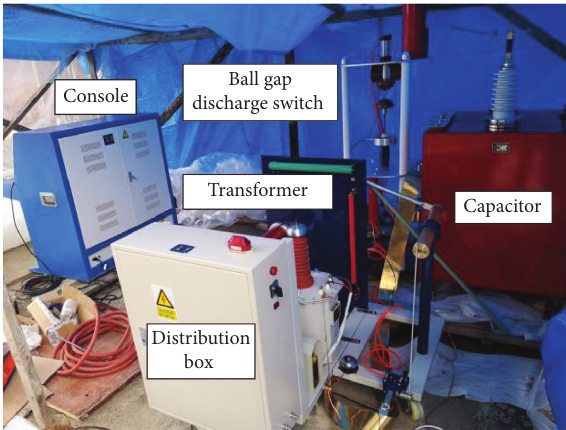
Figure 2: The high-voltage pulse generator.